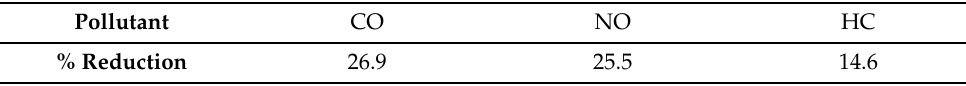
Table 8. Tail-pipe pollutants cumulative emissions.